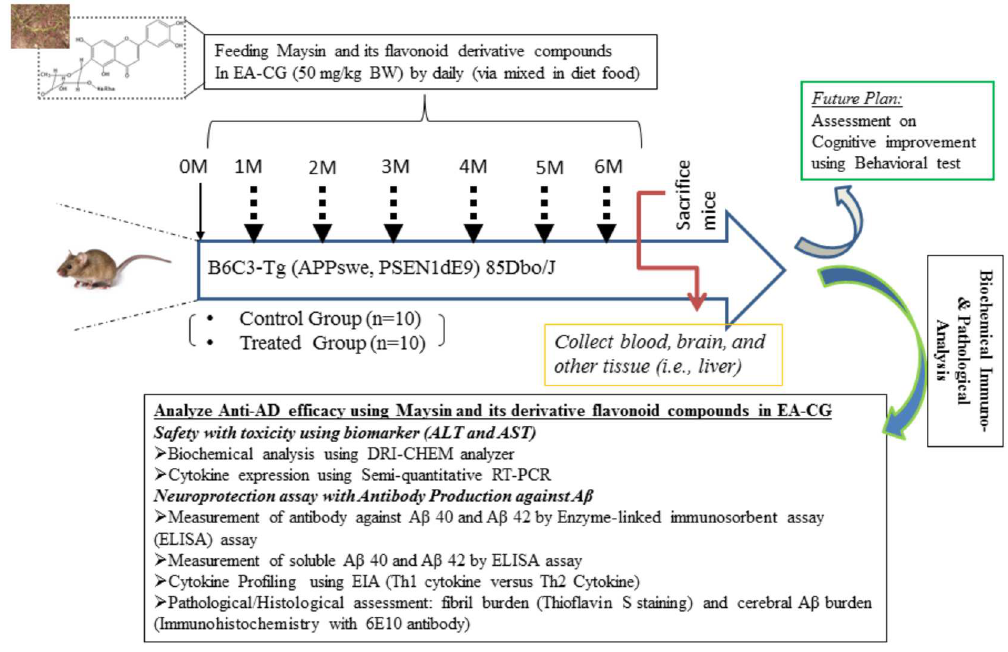
Fig 1. Assessment workflow of novel Anti-AD effectiveness using Maysin and its flavonoid derivative compounds on APP/PS1 AD mice model. Complicationof traumatic brain injury is associatedwith inflammation and neural cell death from inductionof A β 42/40 formation likely due to unfoldedcerebralplaqueor fibril form which results from genetic alterationin APPswe and PSEN1dE9 in the 85Dbo/J mice model for Experimental AD study. Experimental designfor treatment and samplingprocedureas the objectivesin animal model to understandanti-AD of Maysin flavonoidwith respect to prevention and/or prophylactic effect against A β 40/42 mediated neuronal-toxicity and functionaldelineation as the assessment workflowin animal study are